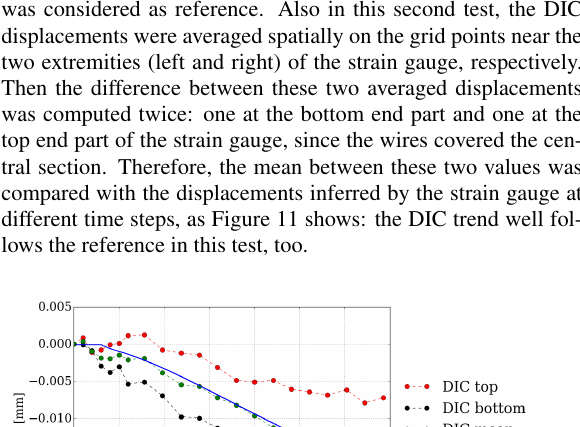
formed at different time steps and the vertical displacements ∆ v versus time are plotted in Figure 10.